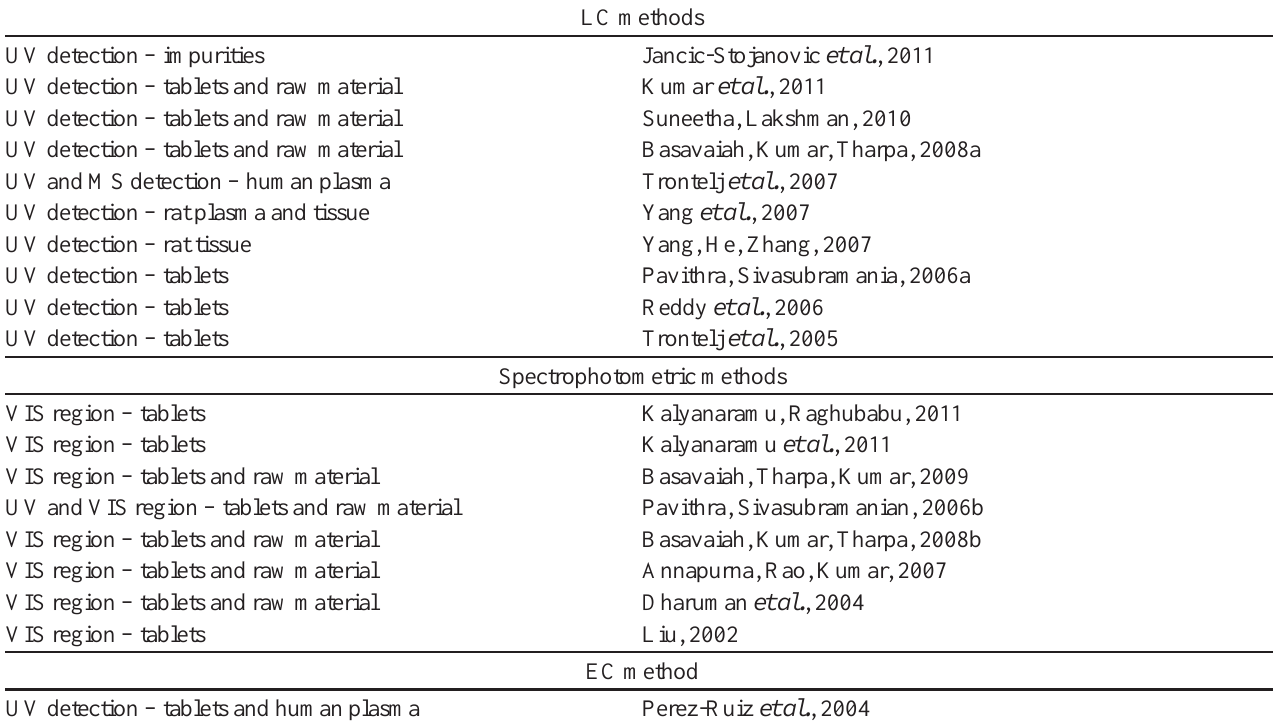
TABLE I - Proposed methods for quantification of RLX by LC, CE and